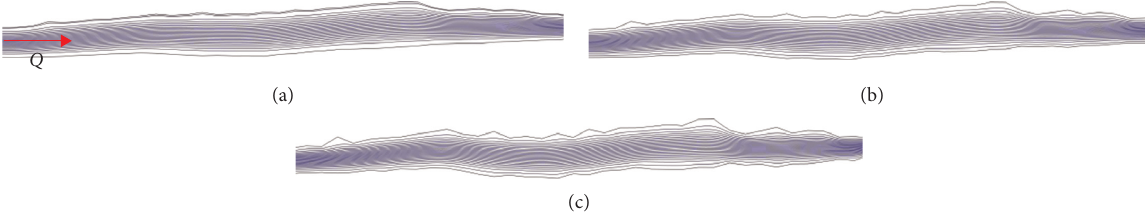
Figure 7: Diagram of streamline distribution for δ � 0.21 mm, Q � 2.152 × 10 − 6 · m 3 /s ( y � 20mm, flow direction x � 25 ∼ 40 mm). (a) D � 2.1. (b) D � 2.3. (c) D � 2.5.